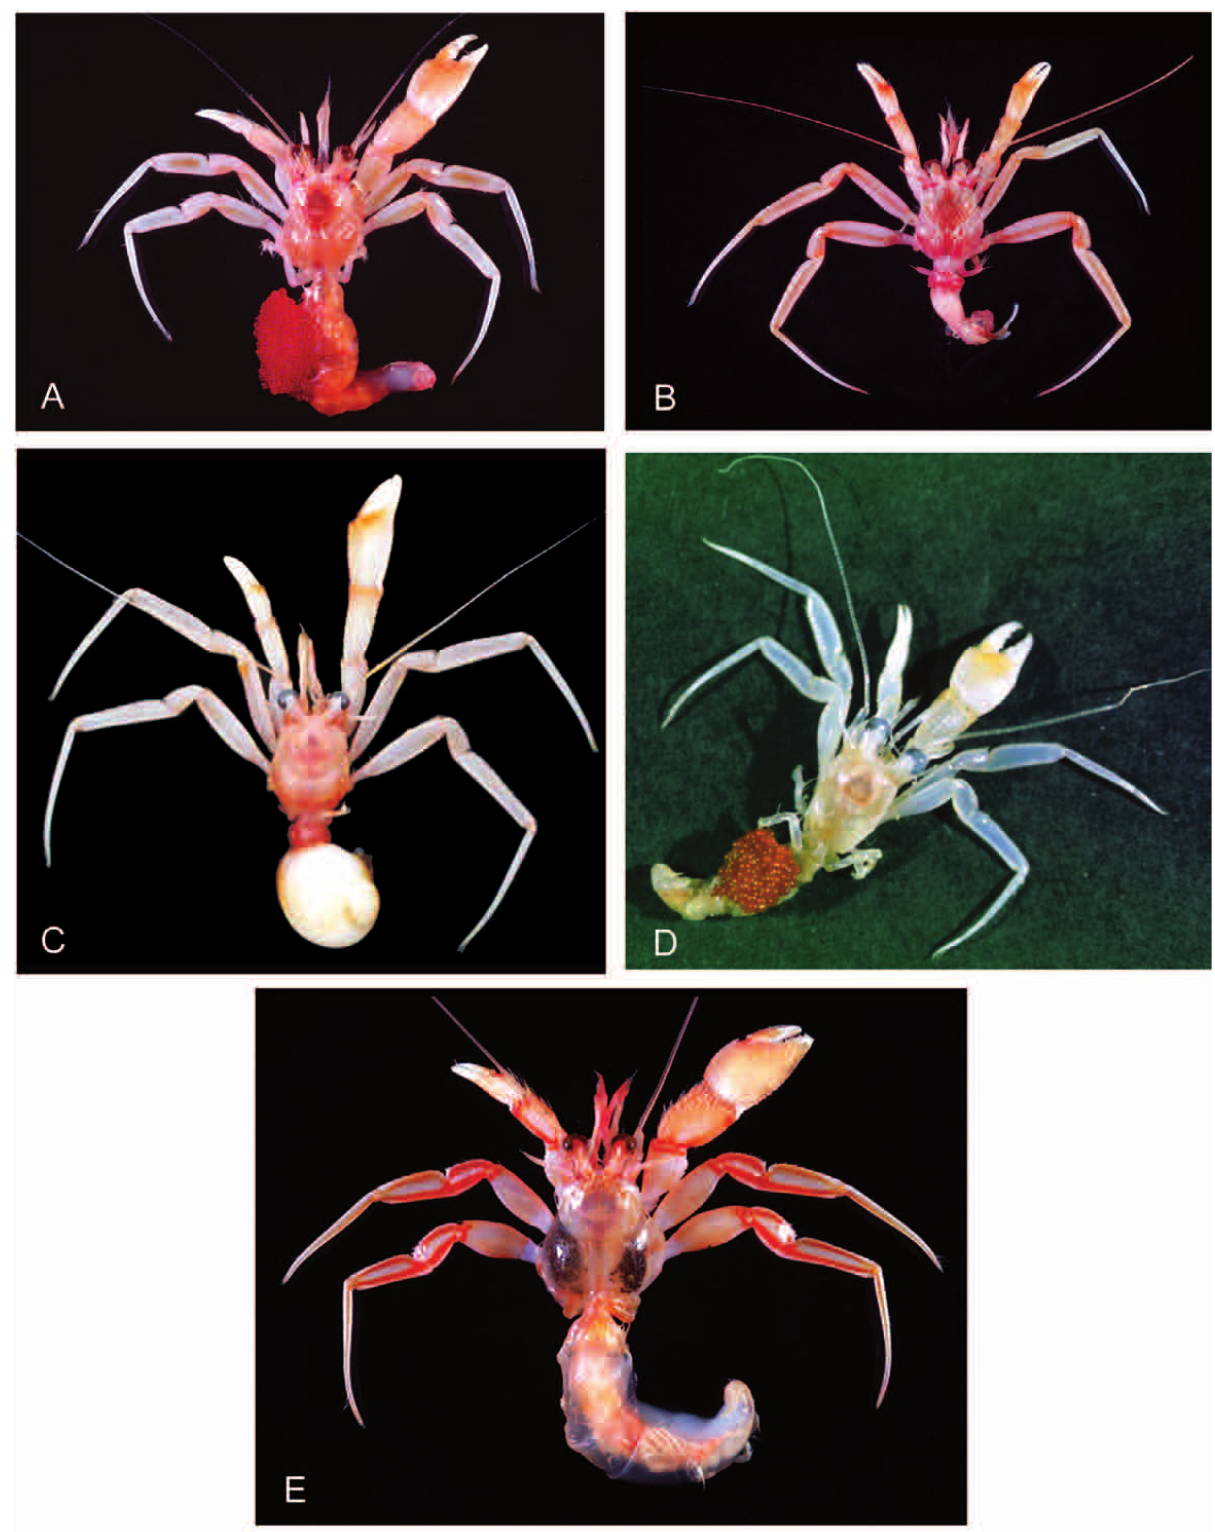
Fig. 8.— Live coloration. A-D, Strobopagurus gracilipes (A. Milne-Edwards, 1891): A, ov F 5.1 mm, TAIWAN 2003, stn CP 214 (NTOU A00001); B, M 6.0 mm (with abnormal right cheliped), same station (NTOU A00001); C, M 6.1 mm, French Polynesia, BENTHAUS, stn CP 1965 (MNHN Pg 6594); D, ov F 3.8 mm, French Polynesia, BENTHAUS, stn DW 1863 (MNHN Pg 7003). E, Strobopagurus sibogae (de Saint Laurent, 1972): F 6.2 mm, TAIWAN 2003, stn CP 216 (NTOU A0007). Photographs by T.-Y. Chan (A, B, E), and J. Poupin (C,